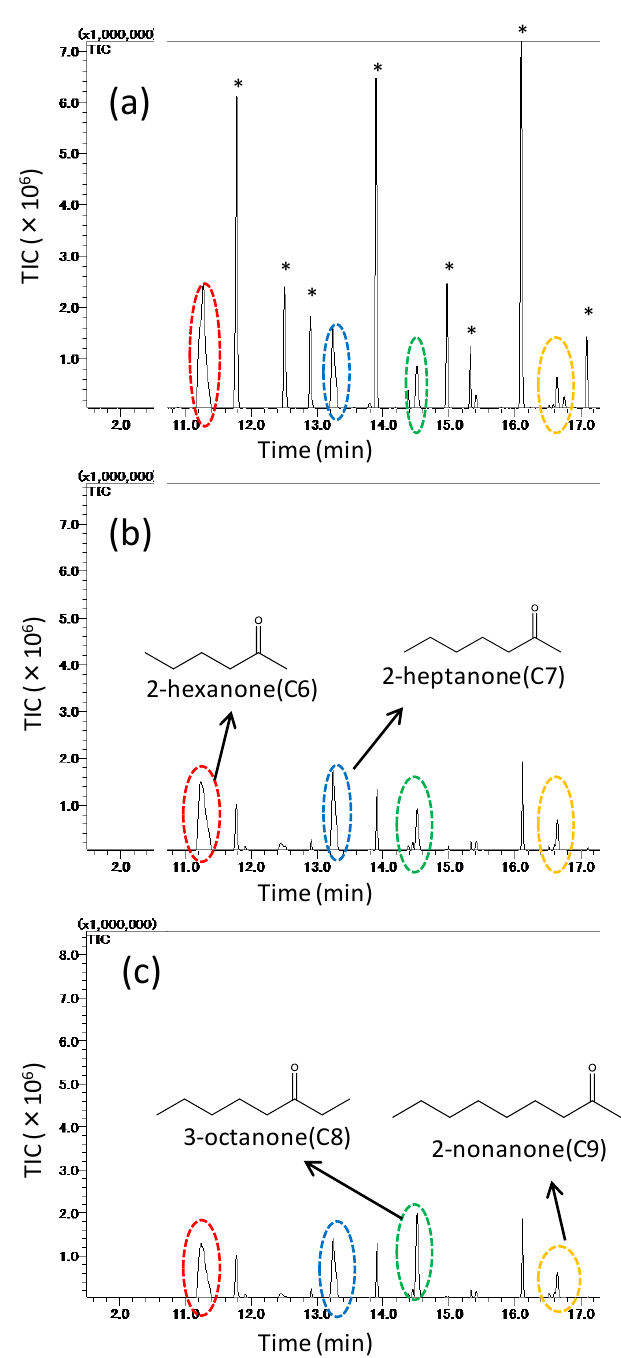
Figure 8. Chromatograms from 11 min to 17 min, comparison of ( a ) untreated PDMS, ( b ) MIFA , and ( c ) MIFA to 2-heptanone 3-octanone